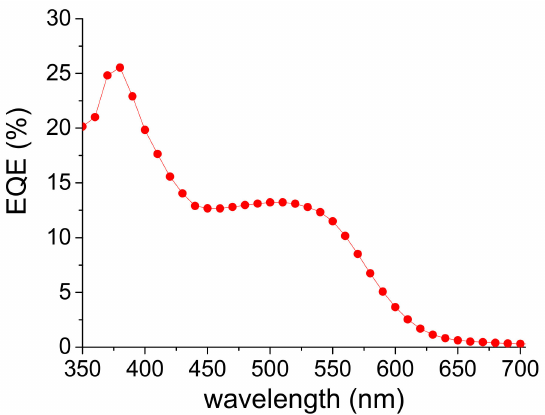
Figure 7. External quantum e ffi ciency (EQE) curve of BDT-C 60 based device (integrated current density J int = 1.71 mA · cm − 2 ).